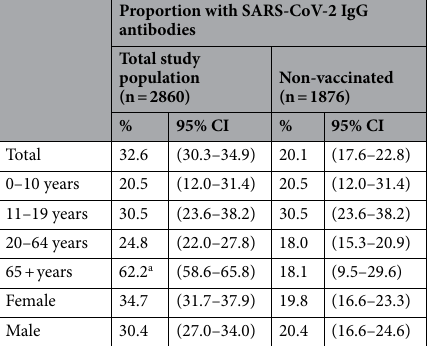
Table 2. Weighted seroprevalence with 95% confidence interval in the total study population (n = 2860) and among non-vaccinated (n = 1876), in total and by age group and sex. Sweden April 26–May 9, 2021. a Seroprevalence is higher in this age group compared to the other age groups (p < 0.001).